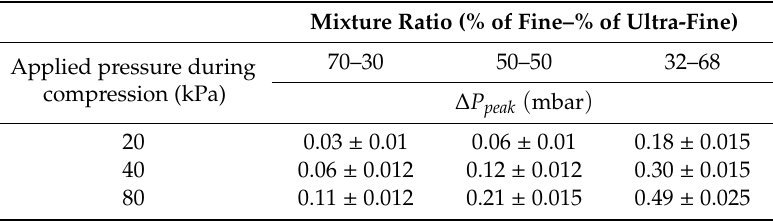
Table7. Di ff erencesbetweenpeaksofbedpressuredrop( ∆ P peak )ininitialfluidizationandre-fluidization Table 7. Differences between peaks of bed pressure drop ( 𝛥𝑃 (cid:3043)(cid:3032)(cid:3028)(cid:3038) ) in initial fluidization and re- after compression, in mbar (Mean ± Standard deviation). fluidization after compression, in mbar (Mean ± Standard deviation)